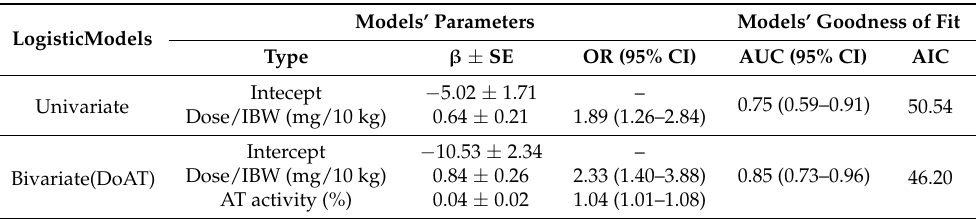
Table 2. Logistic regression models predicting protective anticoagulation (anti-FXa > 0.3 IU/mL) in severe nephrotic syndrome.